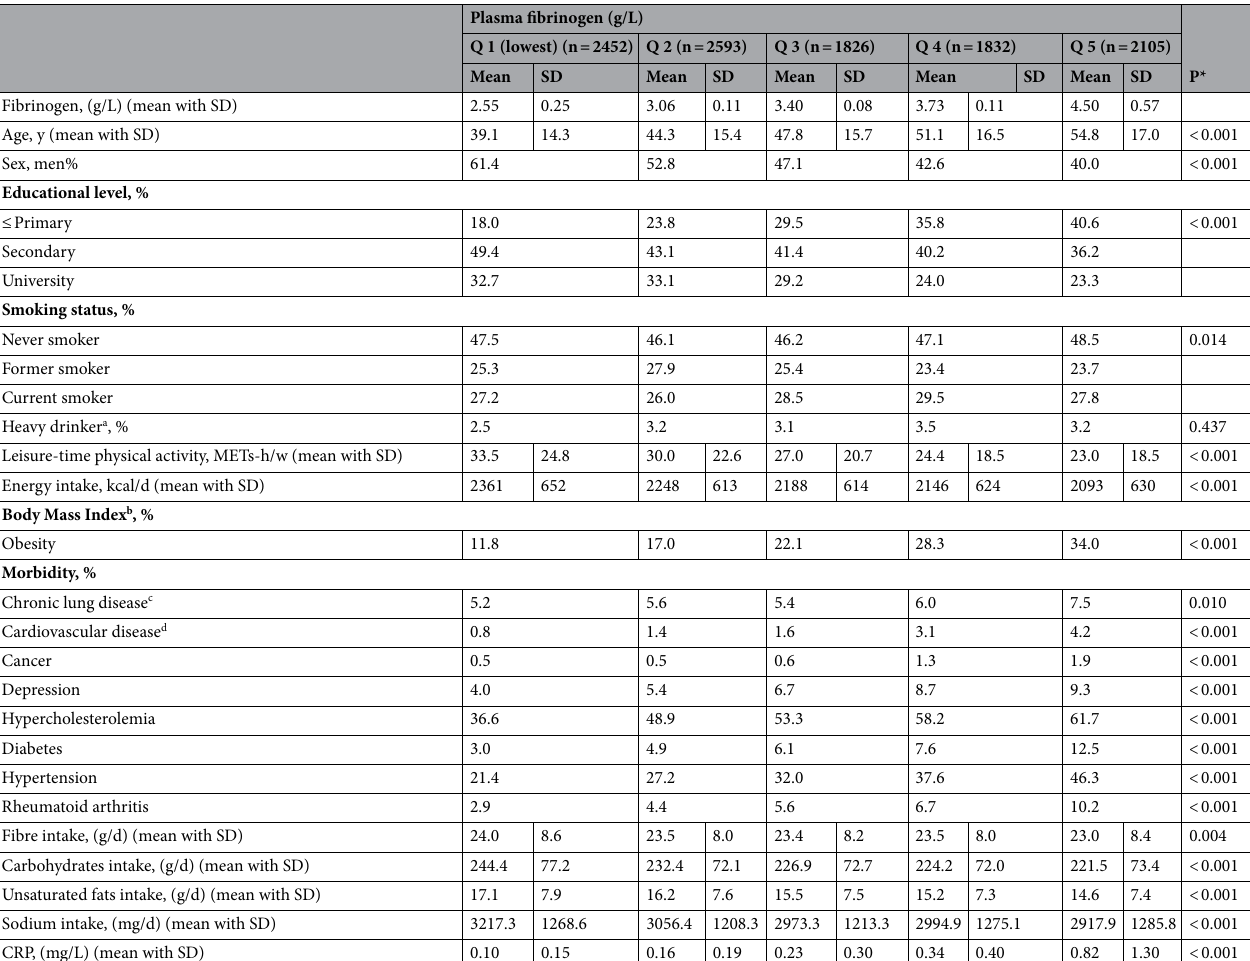
C-reactive protein. * P of the statistical significance differences between quintiles of plasma fibrinogen using the Chi-square, ANOVA or Kruskal–Wallis tests. a Average alcohol intake ≥ 40 g/day in men and ≥ 24 g/day